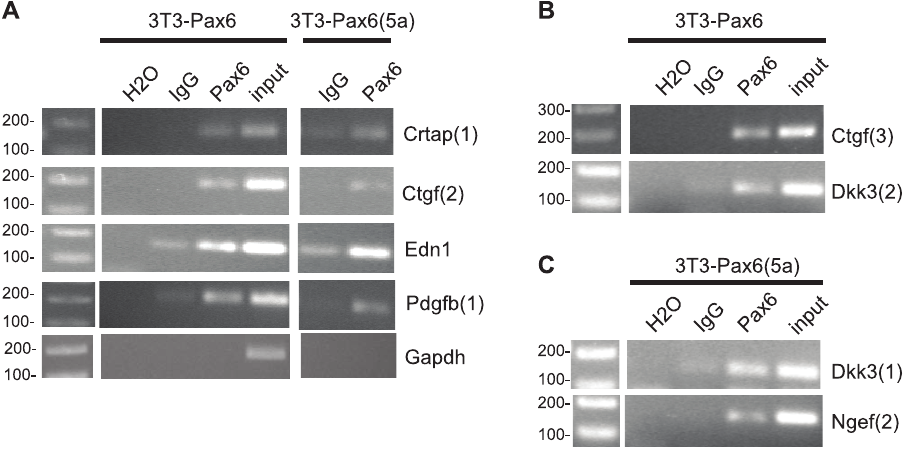
Figure 6. Chromatin immunoprecipitation verifies binding of Pax6 and Pax6(5a) to the promoter region of several target genes. Chromatin immunoprecipitation with an antibody against Pax6 was done for both the 3T3-Pax6 and the 3T3-Pax6(5a) cell line. IgG was used as a control. PCR primers were designed so that they should amplify target sequences with putative Pax6 and/or Pax6(5a) binding sites in the promoter regions of Crtap, Ctgf, Edn1, Pdgf, Dkk3 and Ngef. The number in parenthesis specifies the identity of the primerset used for the observed amplification. Genomic DNA sampled before adding the antibody (input) was used as a positive control for the PCR reaction, while water was used as a negative control. The promoter region of Gapdh was included as a region not expected to bind Pax6 or